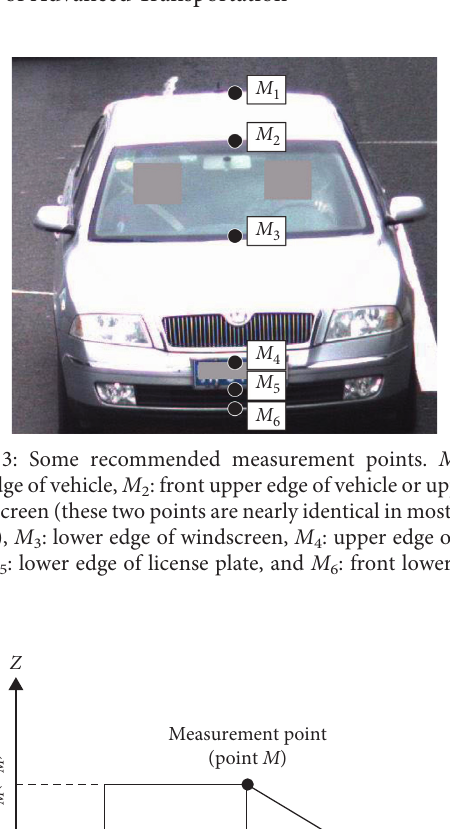
Figure 4: Definitions of measurement point and related